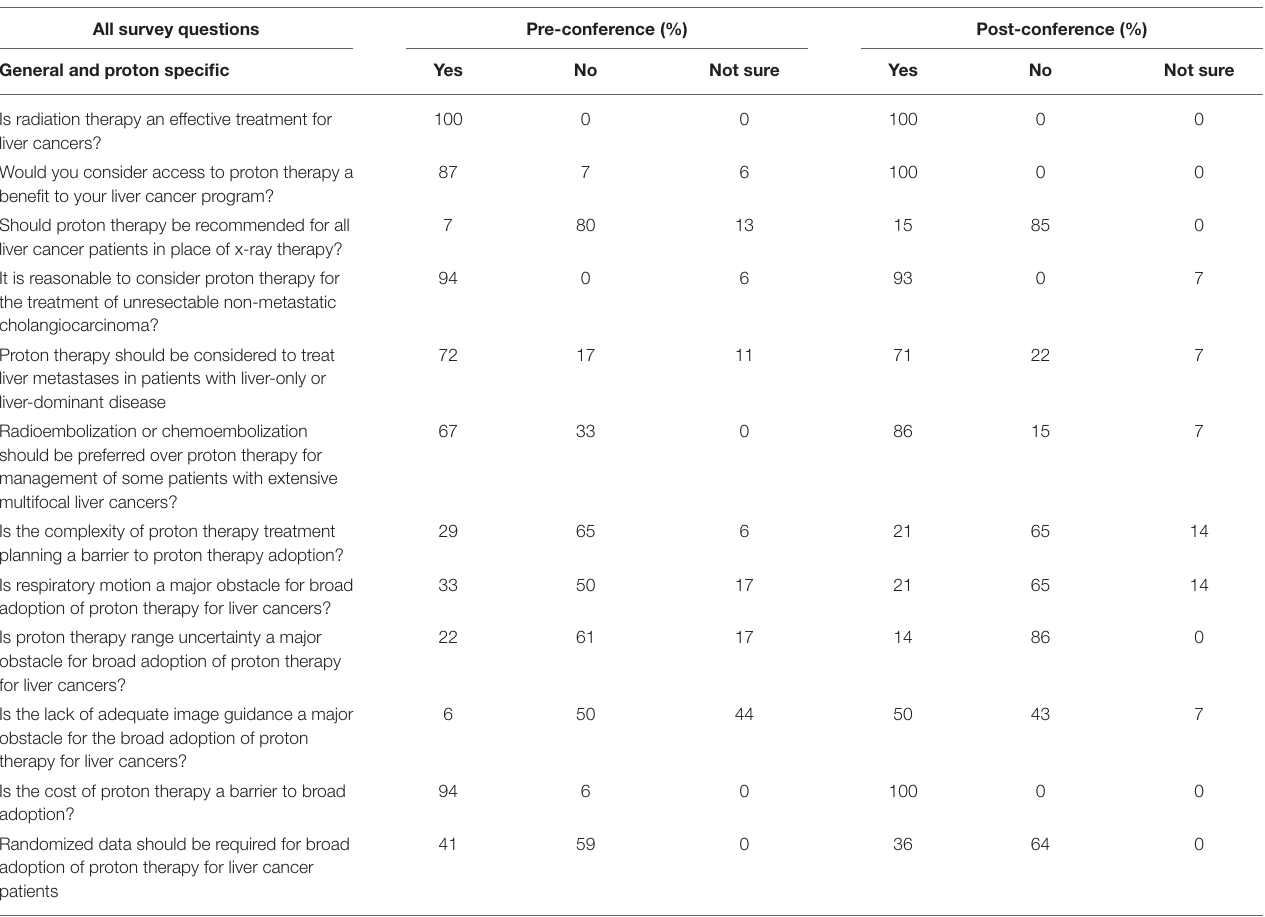
TABLE 1 | Pre- and post-conference participant survey results.